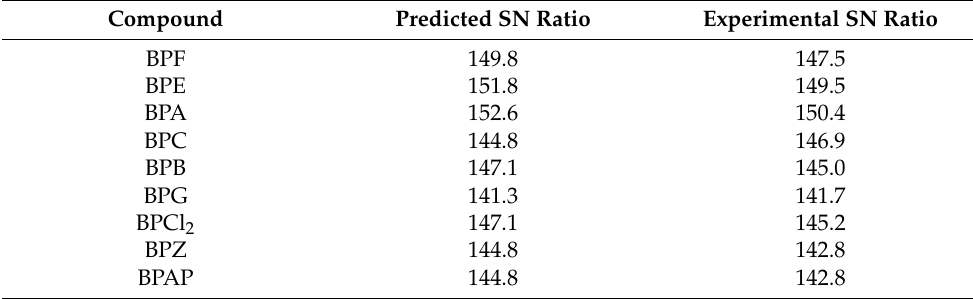
Table 4. Comparison of predicted and experimental SN